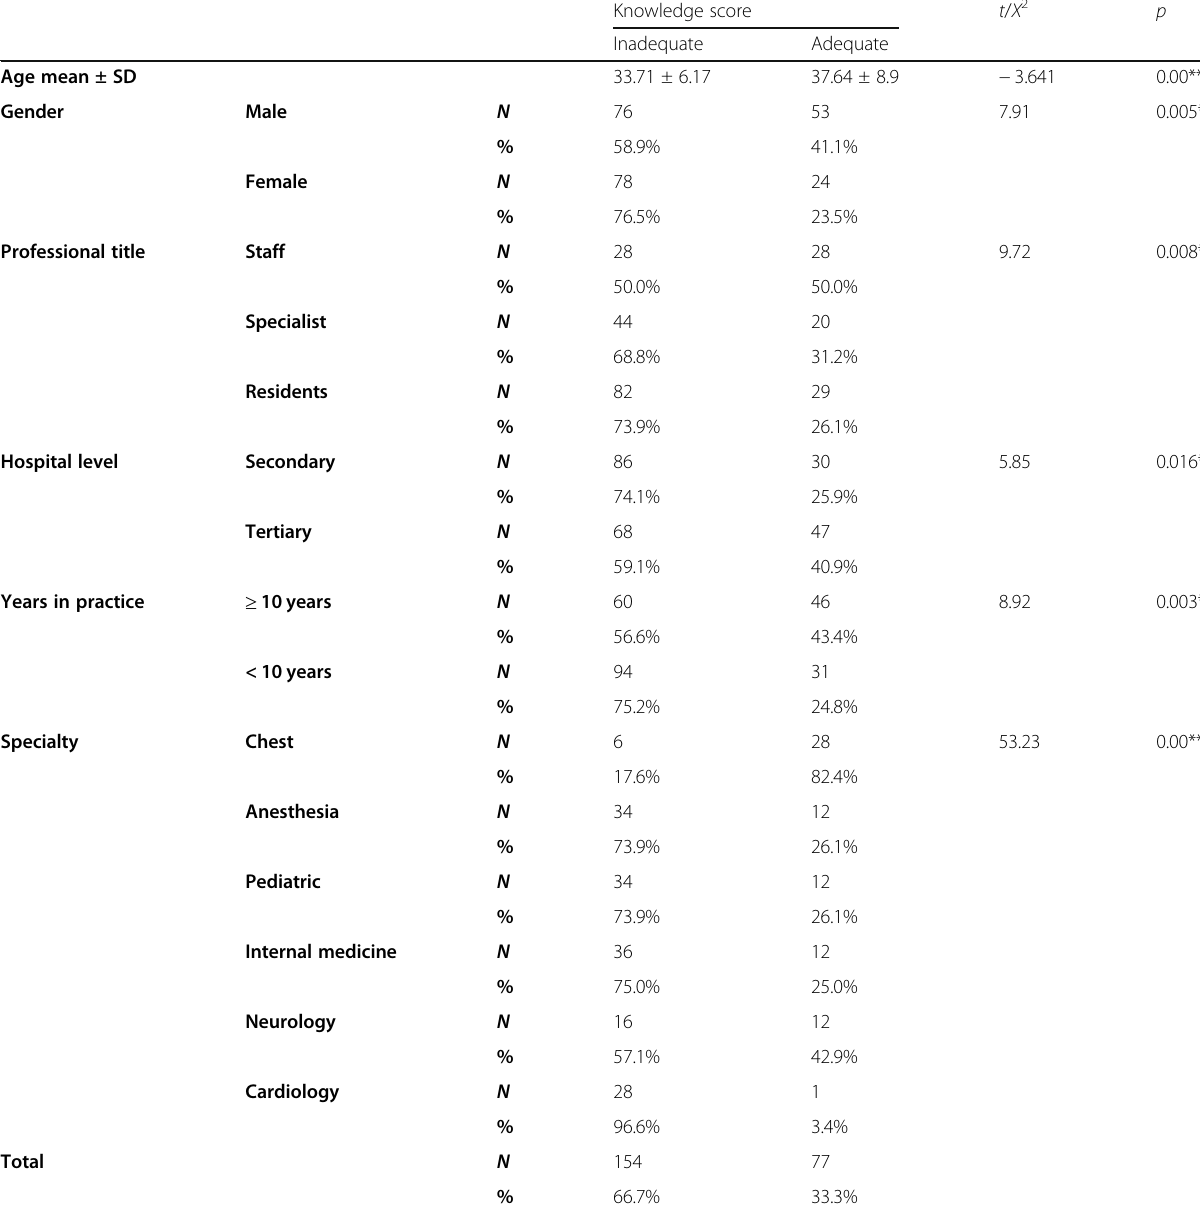
Table 7 OSA knowledge score in relation to physicians ’ demographics